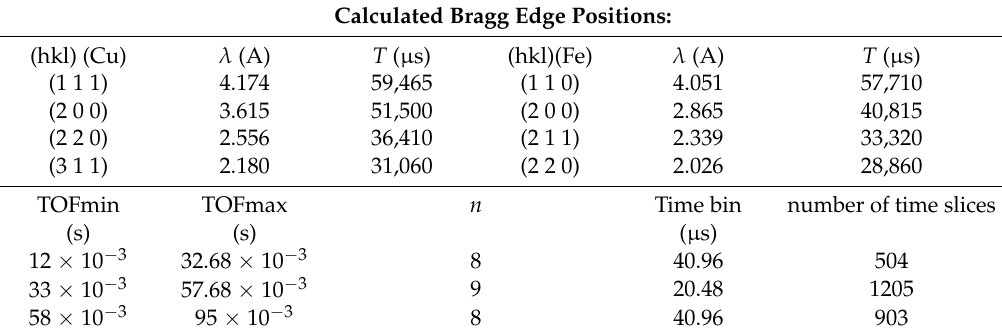
Table 4. Expected Bragg edge positions of Cu and Fe; lower and higher TOF boundaries of MCP shutters (in seconds) indicating the readout gaps, and spanning a total range 12–95 ms. In addition, the trigger signals and acquisition frame are delayed by 20 ms; MCP clock frequency 100 MHz/2 n with clock divider (n); time channel width (in µ s); number of time bins (sum: